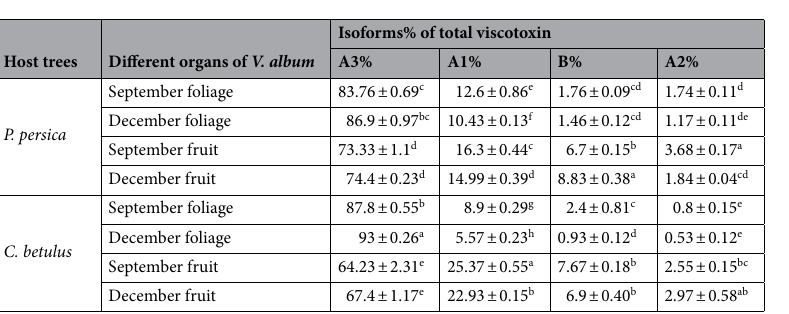
Table 2. Viscotoxin isoforms in the foliage and fruit of V. album settled on P. persica and C. betulus in September and December (% of total viscotoxins). Each value is the mean ± SE (n= 3). Different letters denote significant differences at P ≤ 0.01 using the least significant difference test (LSD